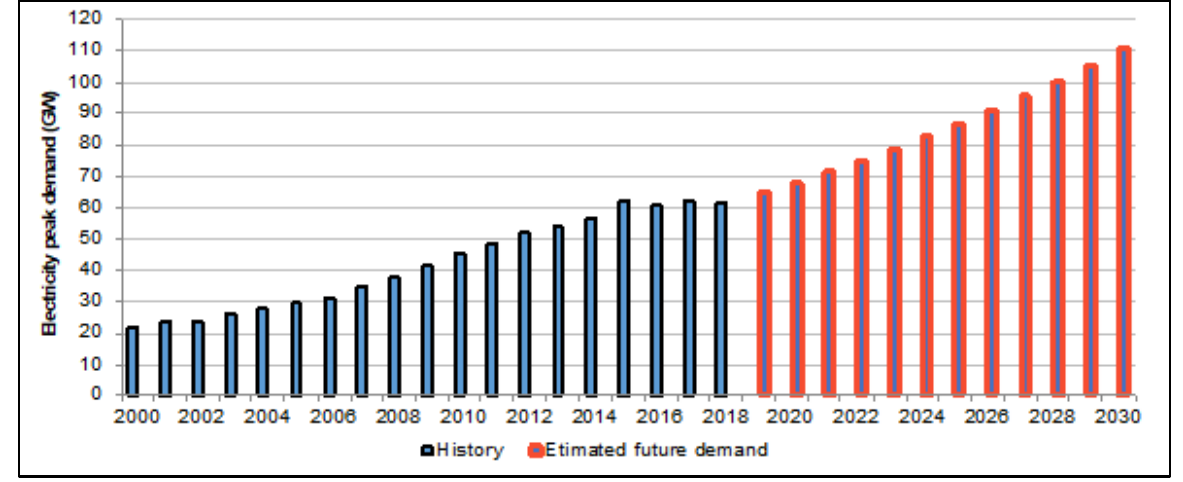
Figure 4. Historical and estimated future demand in the KSA